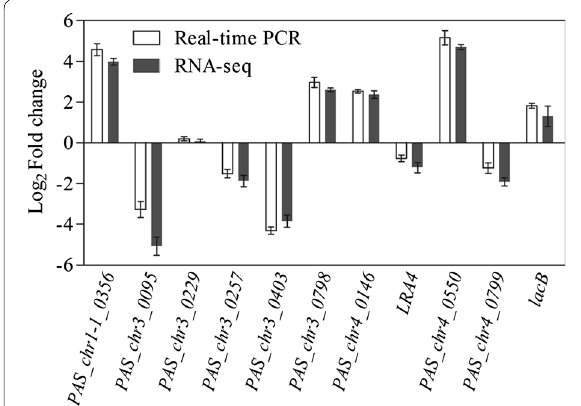
Fig. 2 Correlation of RNAseq and real-time PCR. PAS_chr1 - 1_0356 , hypothetical protein; PAS_chr3_0095 , phenylpyruvate decarboxylase; PAS_chr3_0229 , hypothetical protein; PAS_chr3_0257 , adenylate kinase; PAS_chr3_0403 , Acetyl-coA synthetase isoform; PAS_chr3_0798 , hypothetical protein; PAS_chr4_0146 , hypothetical protein; LRA4 , L-2-keto-3-deoxyrhamnonate aldolase; PAS_chr4_0550 , hypothetical protein; PAS_chr4_0799 , mitochondrial 54S ribosomal protein YmL7/ YmL5; LacB , β-galactosidase. The corresponding gene in P. pastoris GS115/ LacB was used as the control, and the relative expression value of each gene was designated as